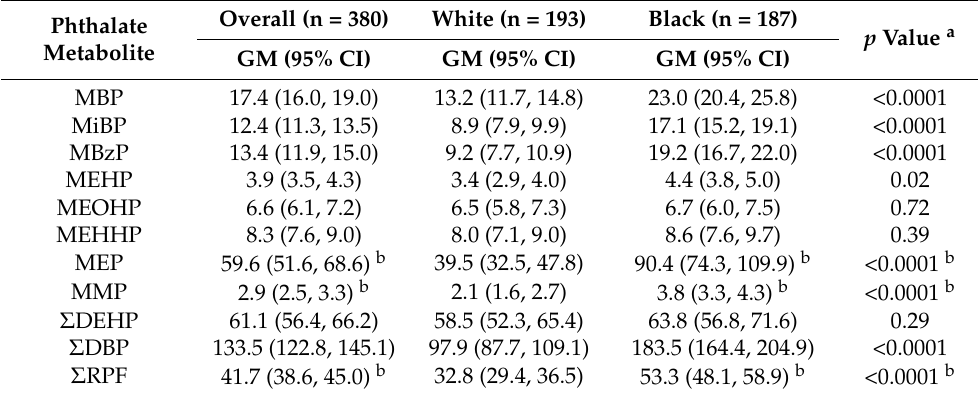
Table 2. Geometric mean (95% confidence interval) concentrations of specific-gravity adjusted phthalates during the 2nd trimester